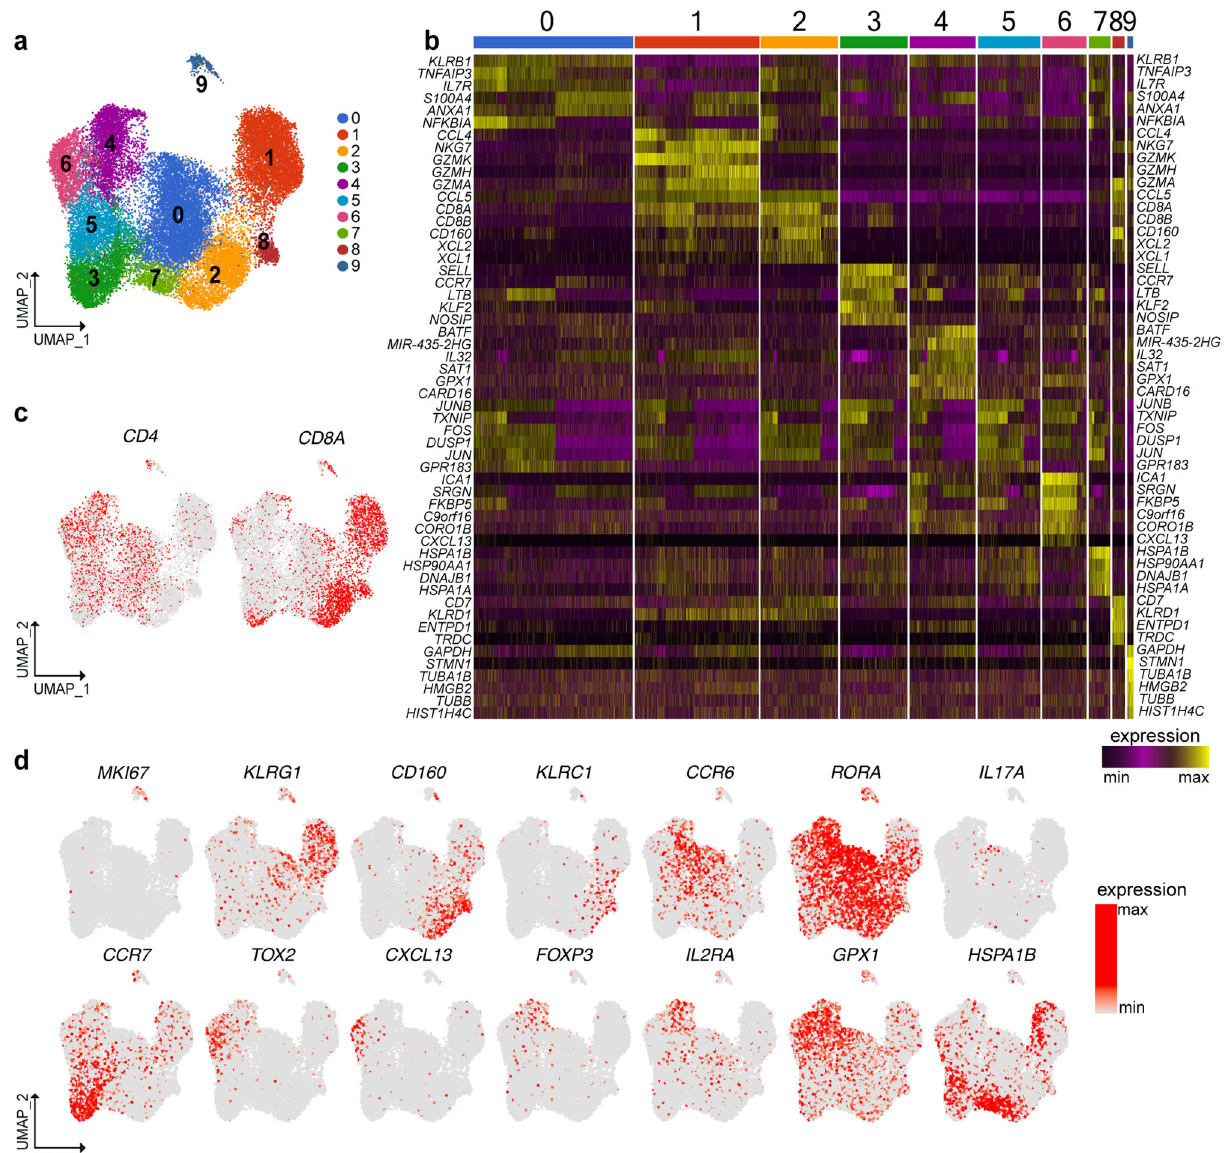
Fig. 5 scRNA-seq of LP T cells identi fi es discrete subsets of CD4 + and CD8 + T cells. a Unsupervised UMAP analysis of LP T cell clusters. T cells were pooled from two controls and two CD patients (9107 cells control, 20,140 cells CD). b Heat map displaying the top ten differentially expressed genes in each cell cluster. c Identi fi cation of CD4 and CD8A expressing cells. d UMAP of representative selected genes associated with the identi fi ed